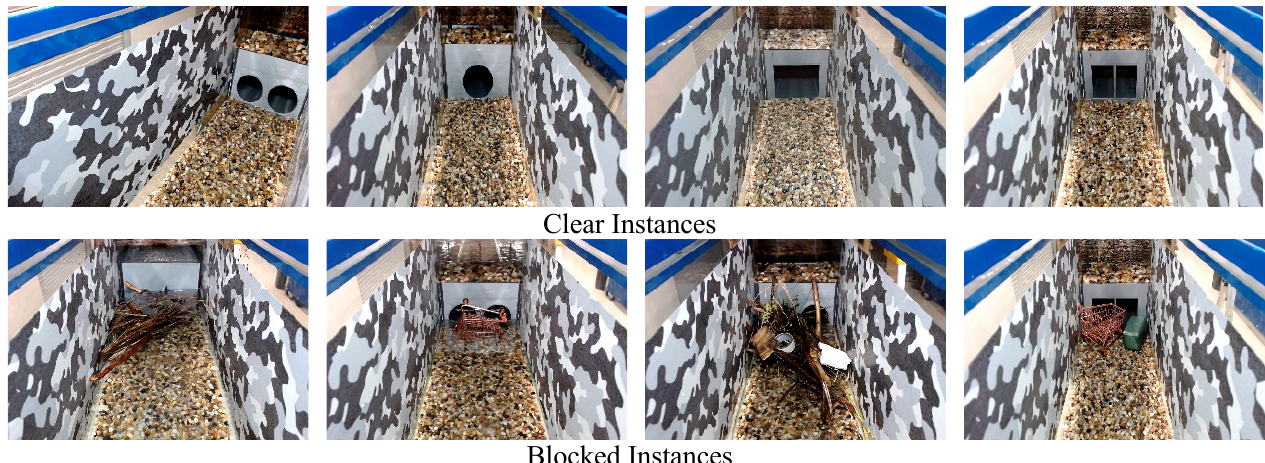
Figure 2. Sample instances of clear (First row) and blocked (Second row) culverts from